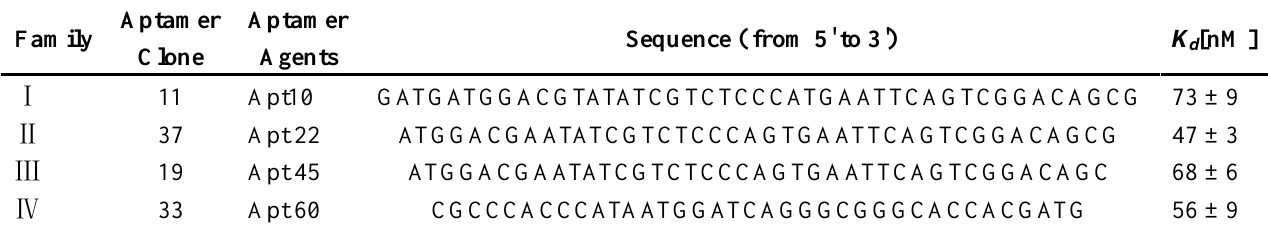
Table 1. Four families of aptamers selected via the SELEX procedure and the sequences and K of their d